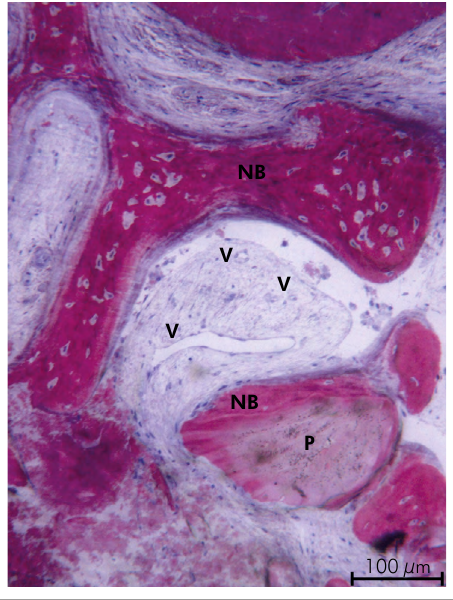
Figure 6. Group 2: in the marrow spaces some blood vessels (v) close to the newly formed bone (NB) and the biomaterial particles (P) undergoing remodeling could be observed. (Toluidine blue and acid fuchsin, 100 x).